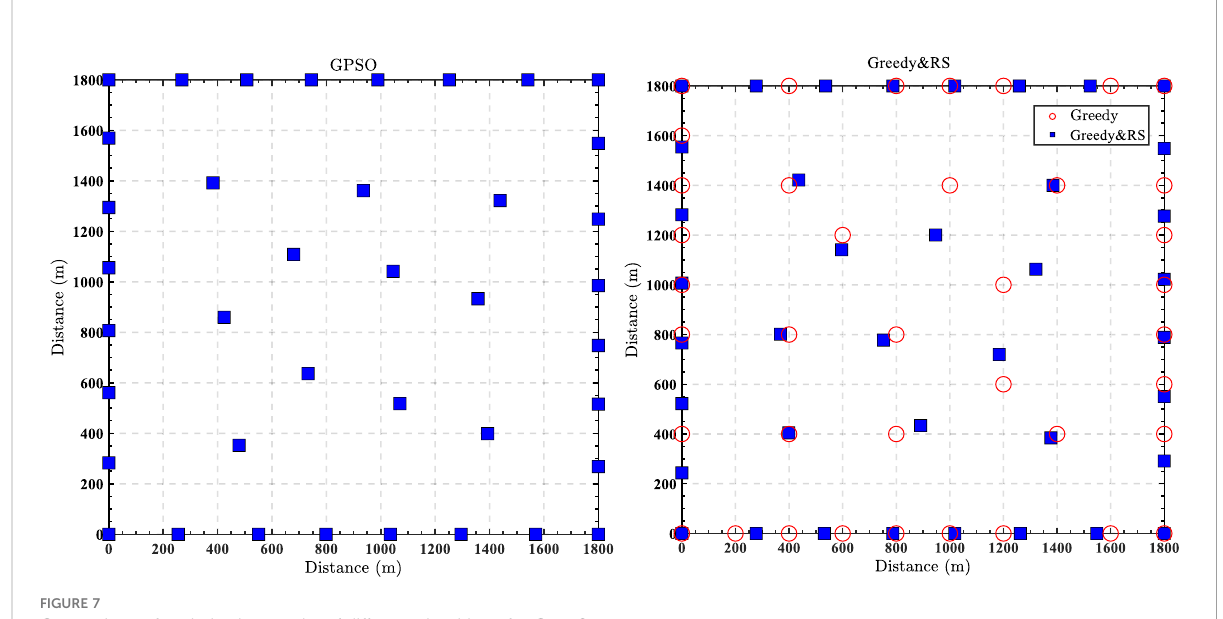
FIGURE 7 Comparison of optimization results of different algorithms for Case